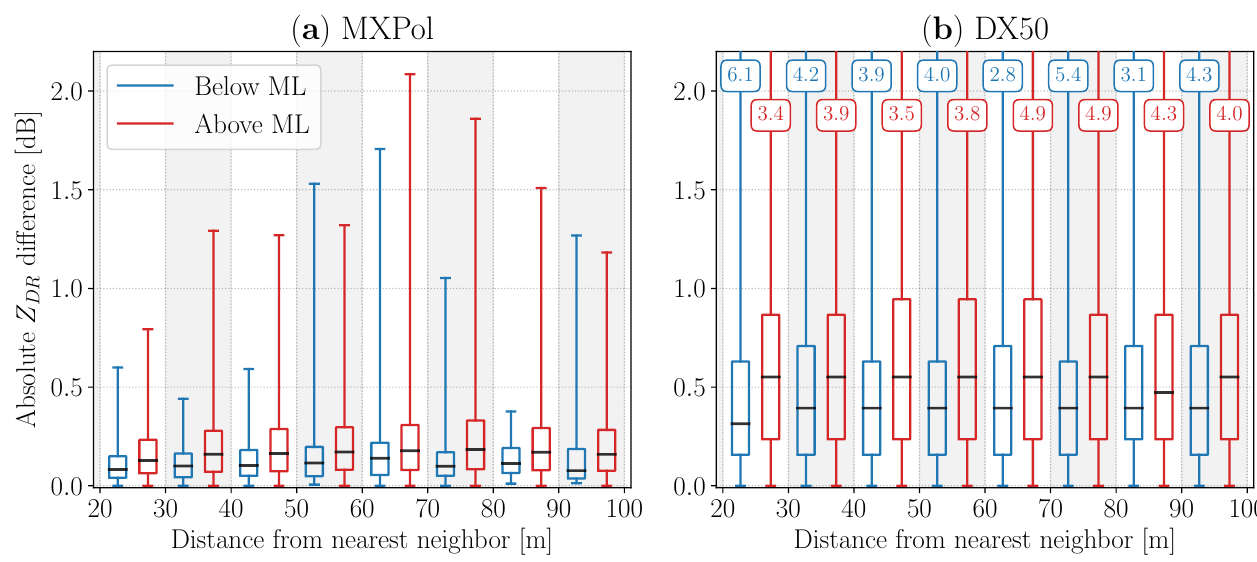
Figure A2. Analysis of the difference of Z DR measurements from couple of radar volumes closest in space. ( a ) The boxplot represent the median (in black), quartiles and minimum/maximum of the distribution of the aforementioned differences below (in blue) and above (in red) the melting layer, for MXPol. The distances of the couples of nearest neighbours have been binned in eight categories, ranging from 20 m to 100 m. Panel ( b ) shows the same analysis for DX50. The number shown in the colored boxes indicates the position of the upper whisker, out of the limits of the axis. For both radars, the full set of measurements has been subsampled for computational